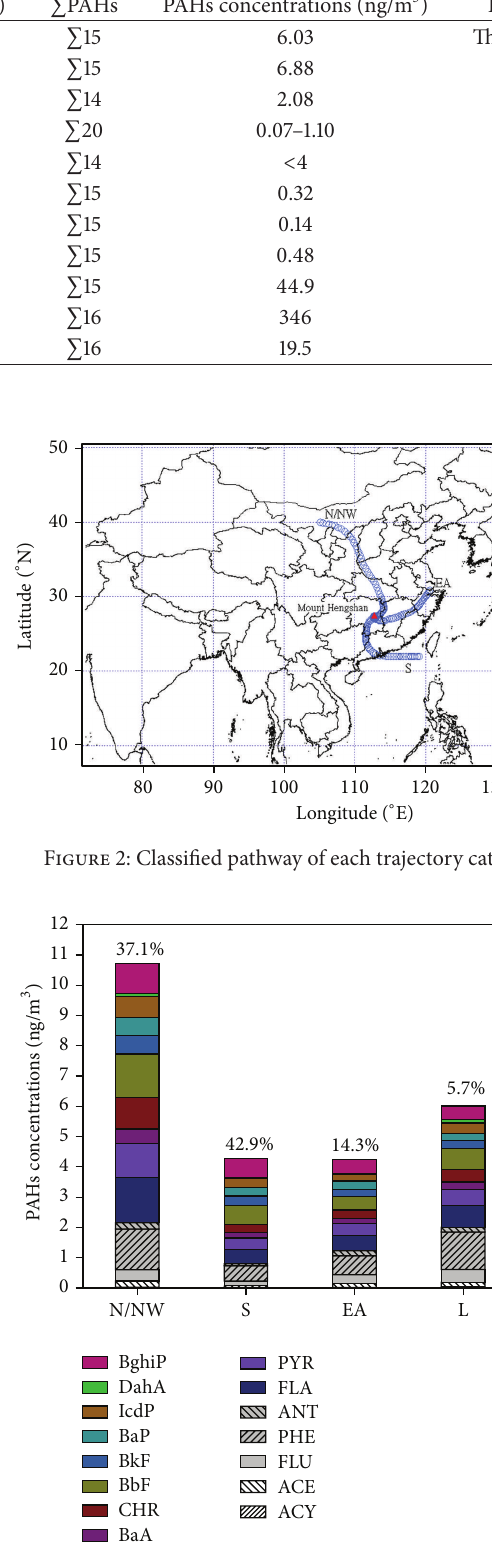
Figure 3: PAHs concentrations based on different trajectory cate-